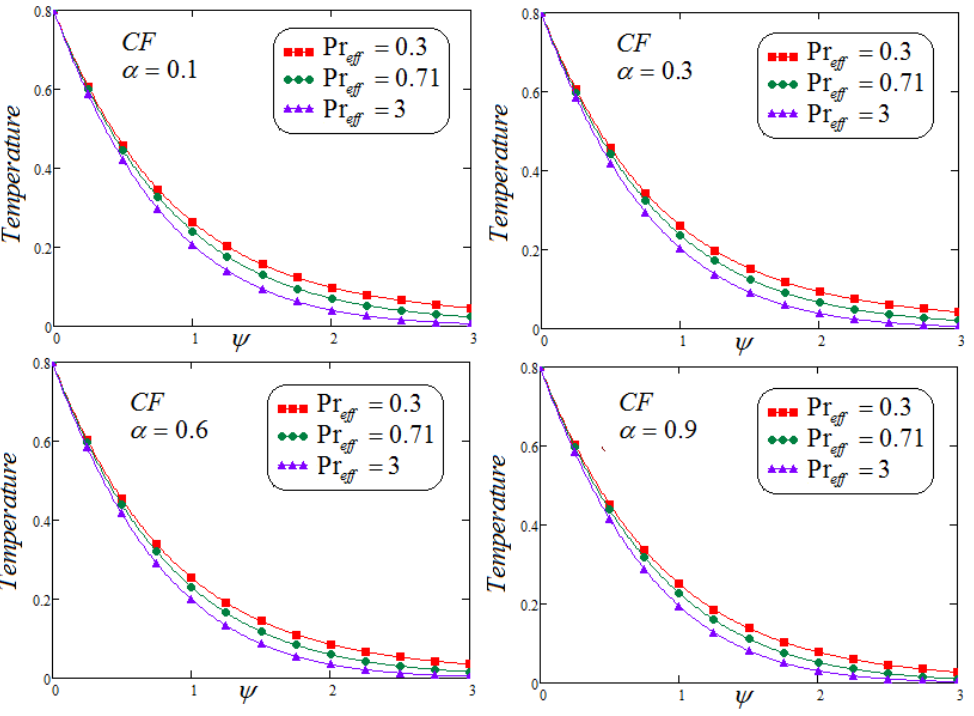
Figure 1. Trace of dimensionless temperature for dissimilar values of Pr ef f via CF.